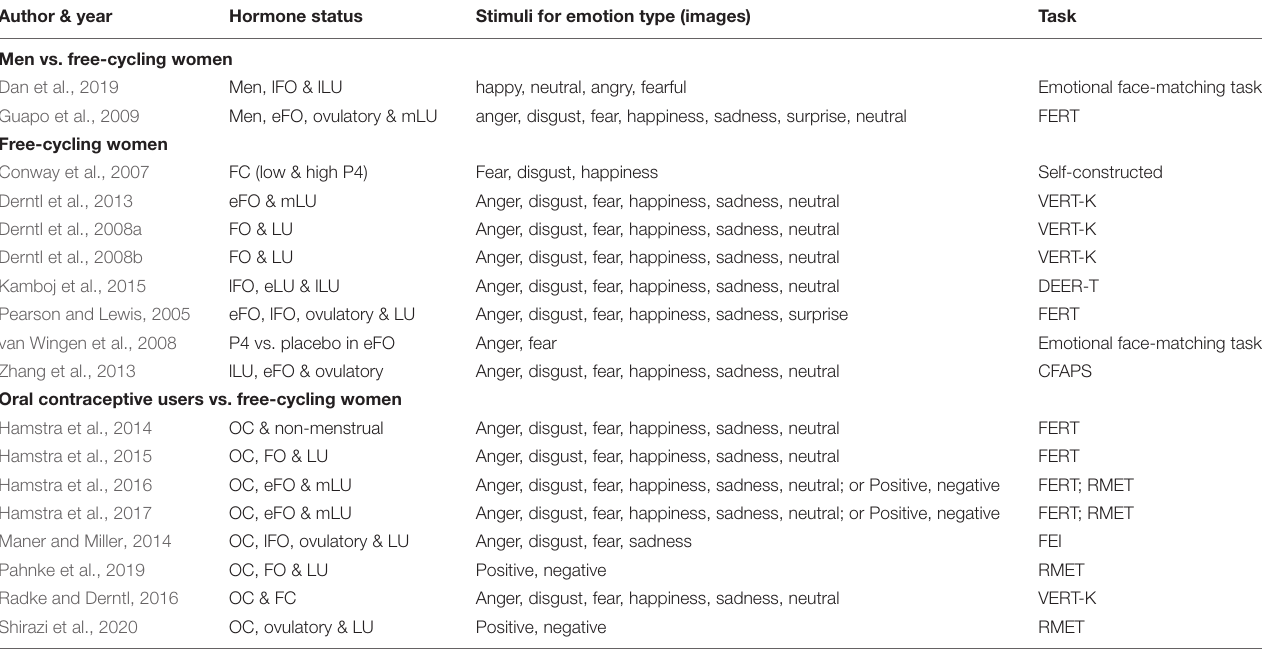
TABLE 2 | Emotion recognition and ovarian hormones: Operationalization of the factors hormone status and emotion type. Author & year Hormone status Stimuli for emotion type (images) Men vs. free-cycling